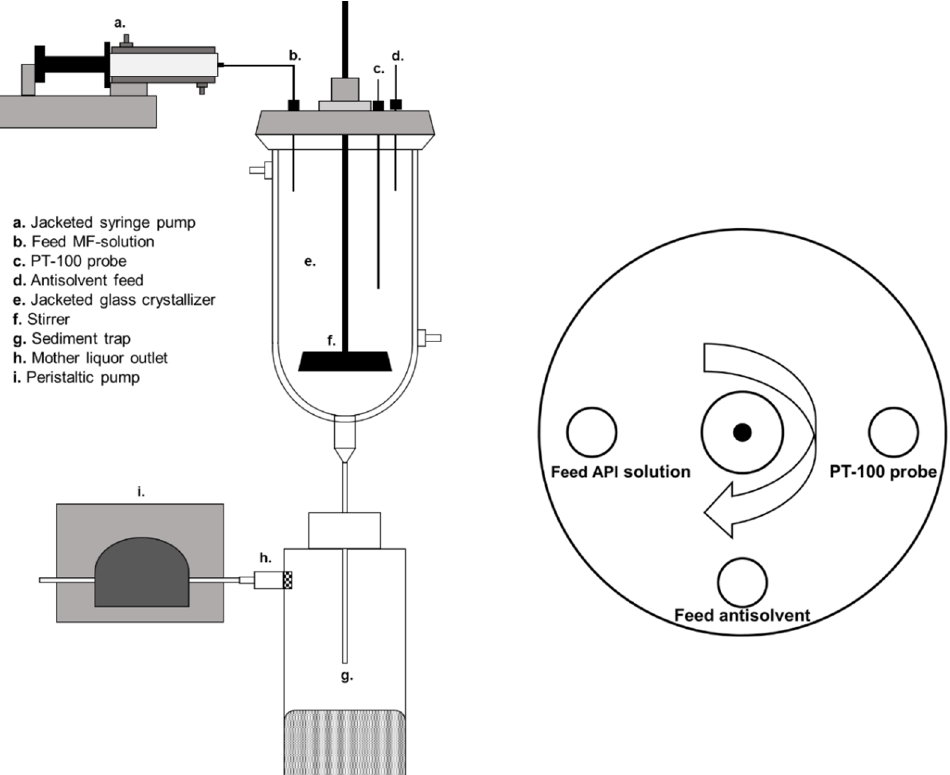
Figure 1. ( left ): MSMPR setup used for QESD crystallizations (the peristaltic pump (i.) is also used to pump fresh antisolvent into the crystallizer through the antisolvent feed line (d.)), ( right ): top view of the ports in the lid of the crystallizer with the direction of stirring (clockwise).